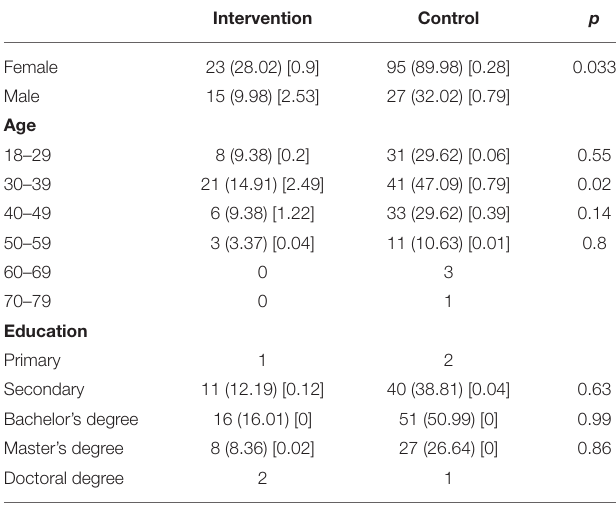
TABLE 7 | Sample demographics according to the third questionnaire.